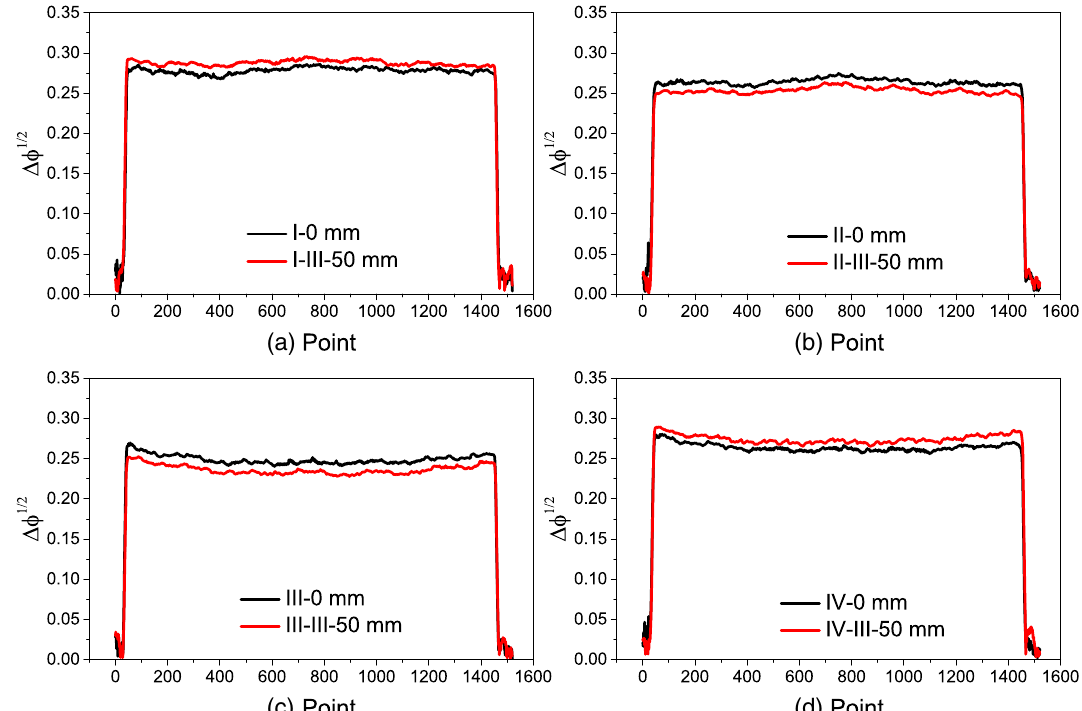
FIG. 20. The electric field of the four quadrants along the RFQ with all the tuners of the third quadrant inserted 50 mm into the cavity. The black line in each graph is the electric field without tuners for